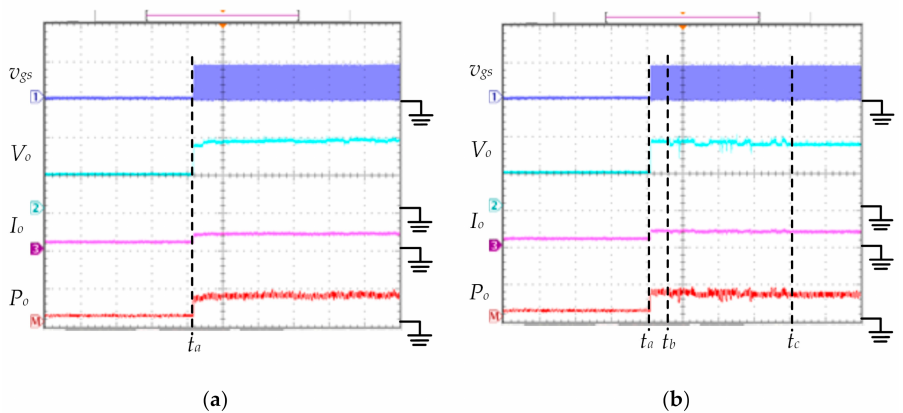
Figure 9. Experimental waveforms of v gs , V o , I o , and P o under UIC that T = 10 ◦ C and G = 0.55 kW/m 2 : ( a ) proposed PVM-QR MPPT and ( b ) HC algorithms. ( v gs : 20 V/div; V o : 20 V/div; I o : 5 A/div; P o : 100 W/div; and Hor: 1 s/div).